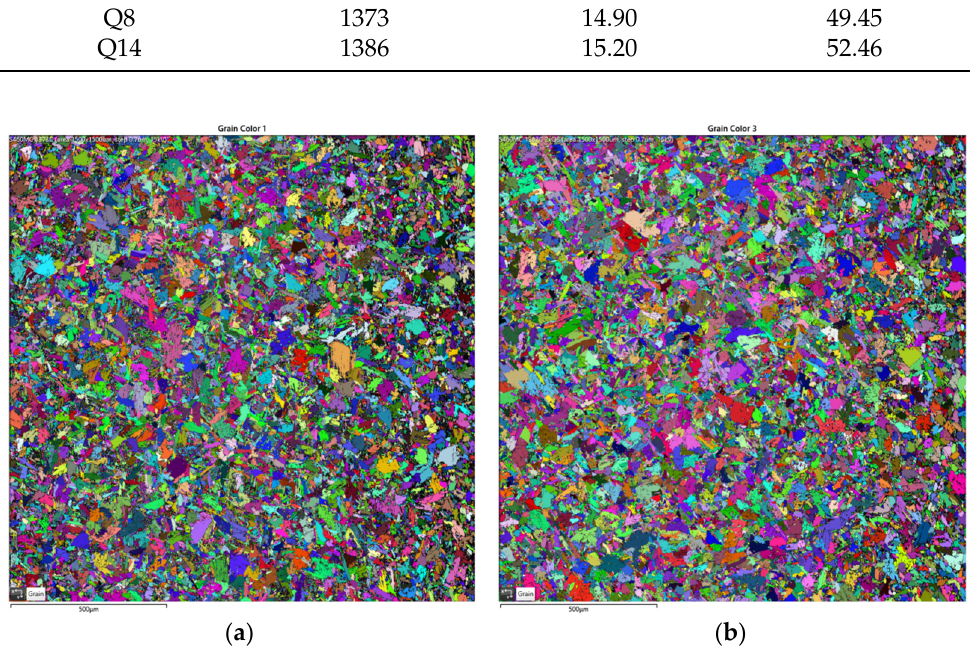
Figure 15. Graphical result of EBSD analysis with the illustration of the individual detected grains ( a )—heat input value 8 kJ·cm − 1 ; ( b )—heat input value 14 kJ·cm − 1 .